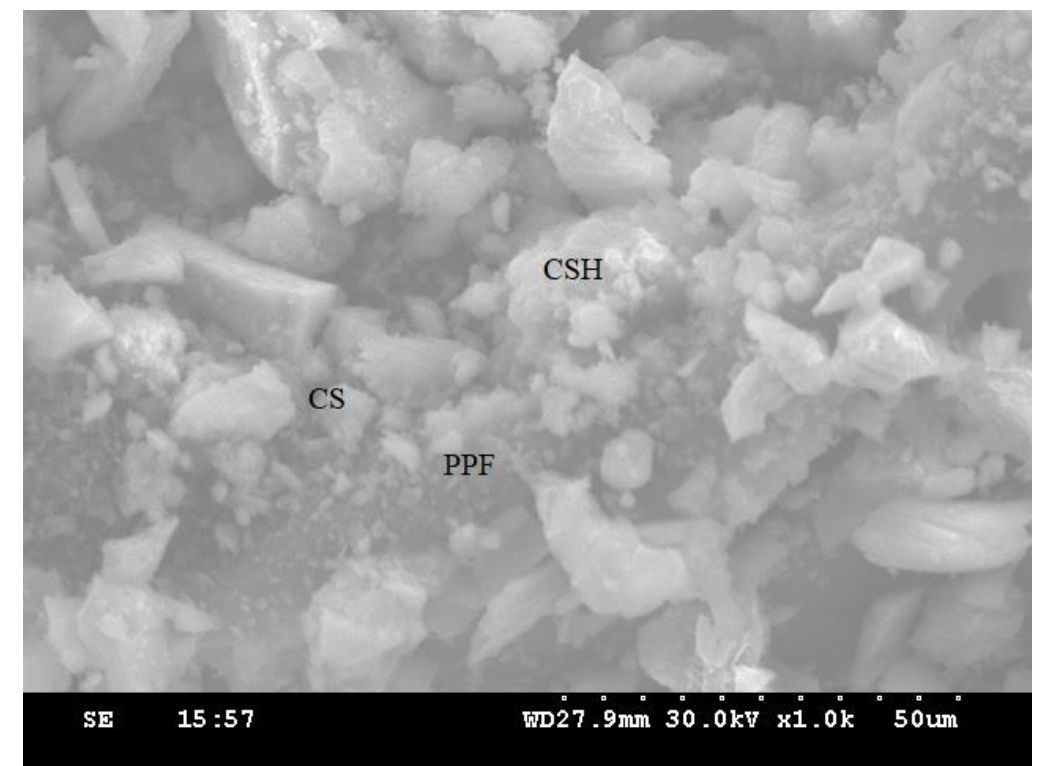
Figure 12. Microstructure of C20P3 composition.